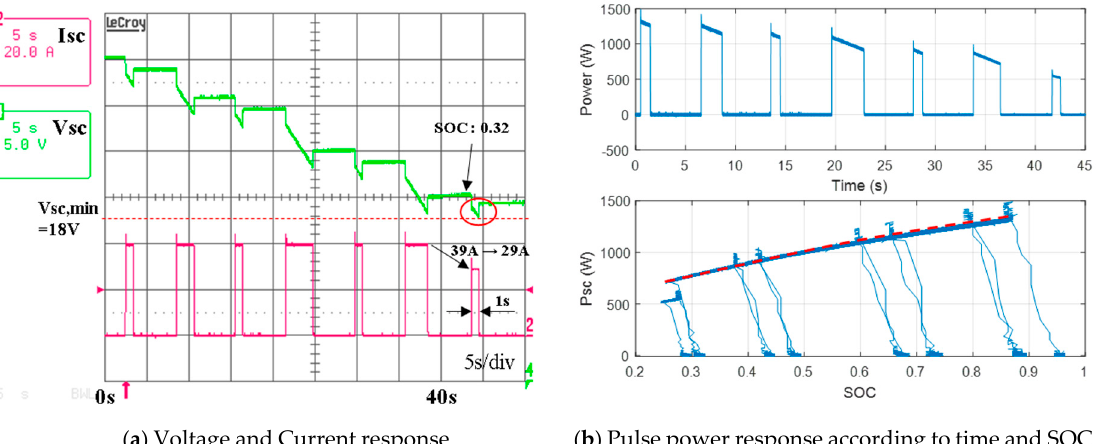
Figure 16. Pulse power estimation result of supercapacitor for verification of the proposed method.